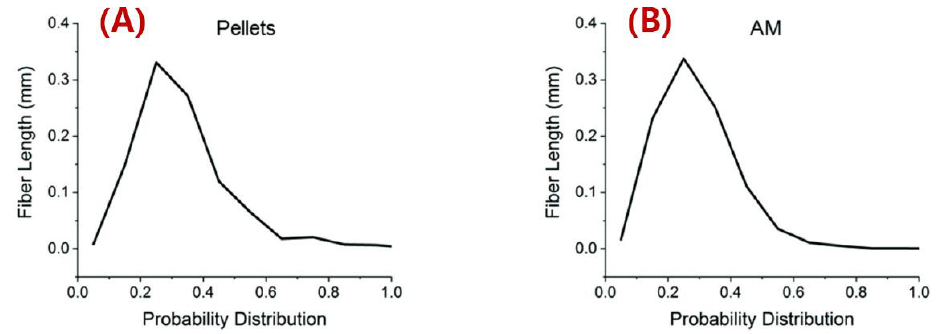
Figure 15. Probability distribution of fiber length: ( A ) pellets; ( B ) deposited beads [100].